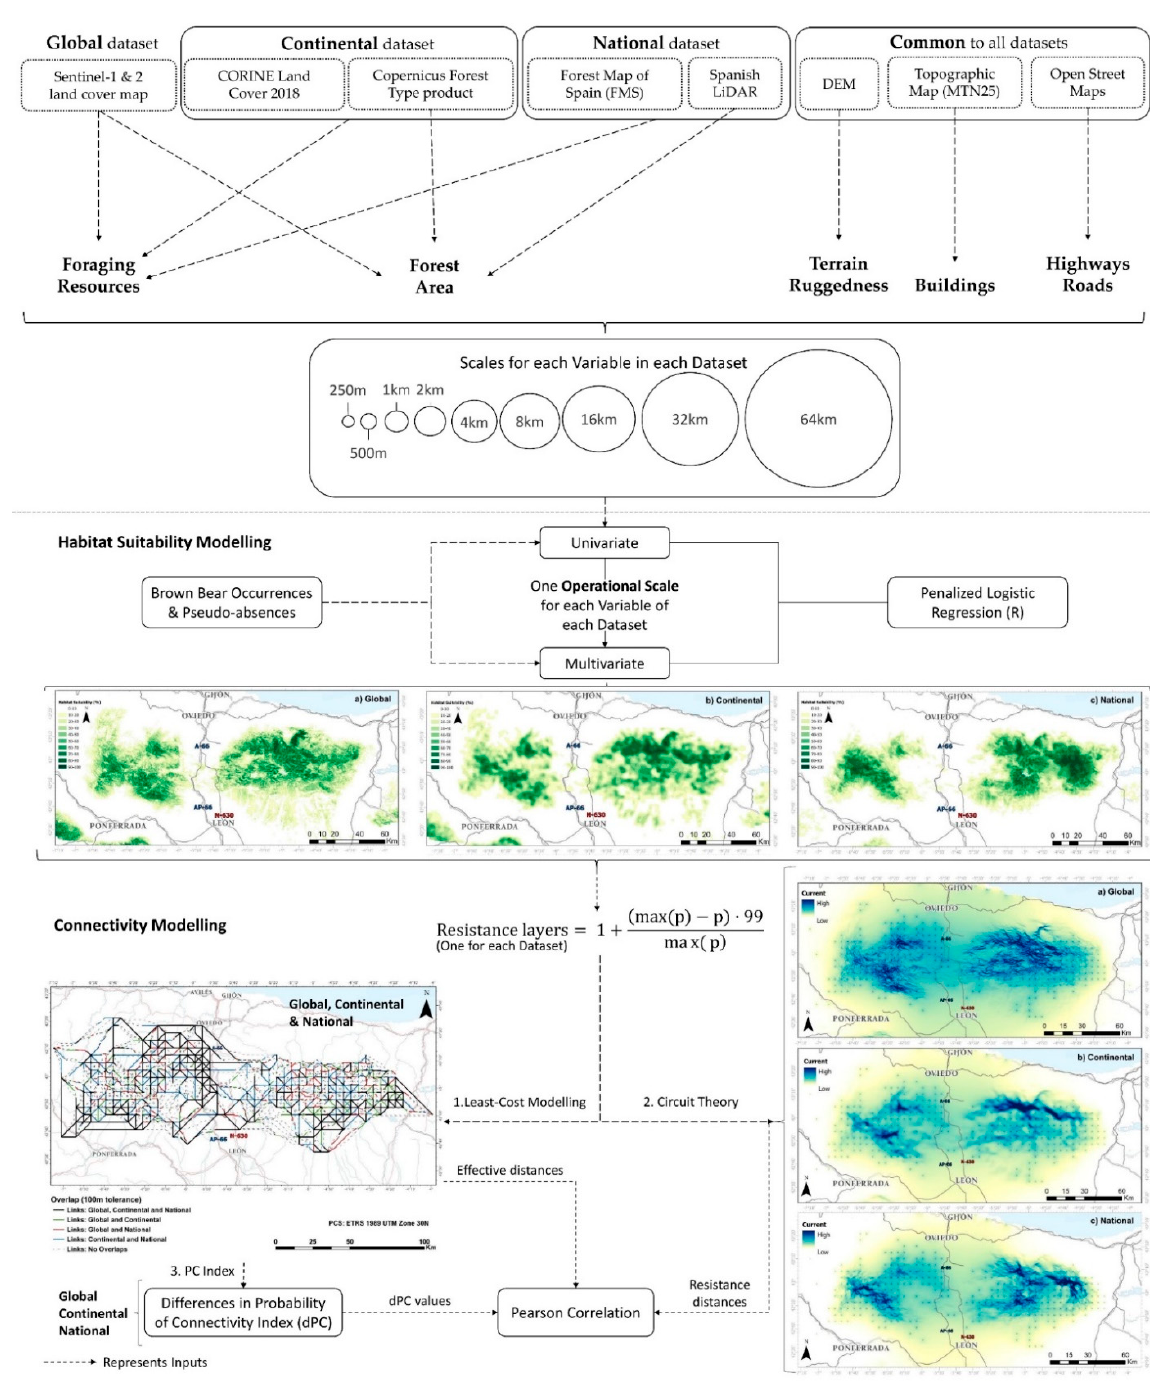
Figure 1. Workflow of the methodology followed including the estimation of environmental variables, habitat suitability modeling and connectivity modeling. In the formula, (p) is the habitat suitability value of each